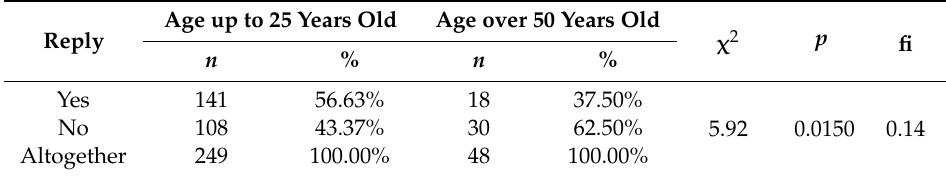
Table 14. Study about the motivation to participate in the Poznan Half Marathon in the future—depending on age.